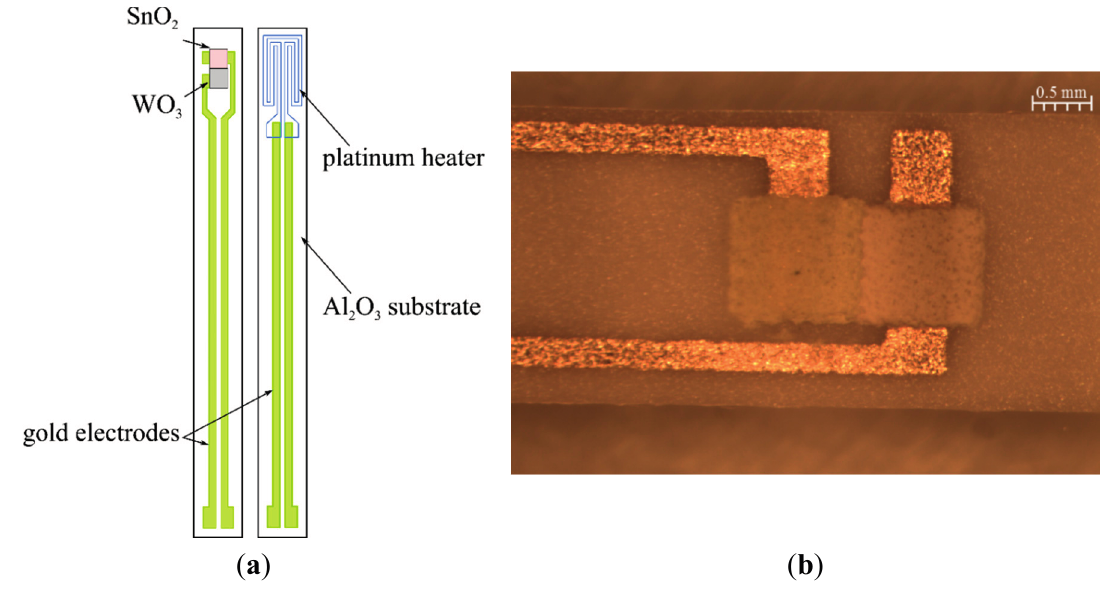
Figure 1. ( a ) Schematic diagram of a sensor; ( b ) Ready-made resistance sensor with a